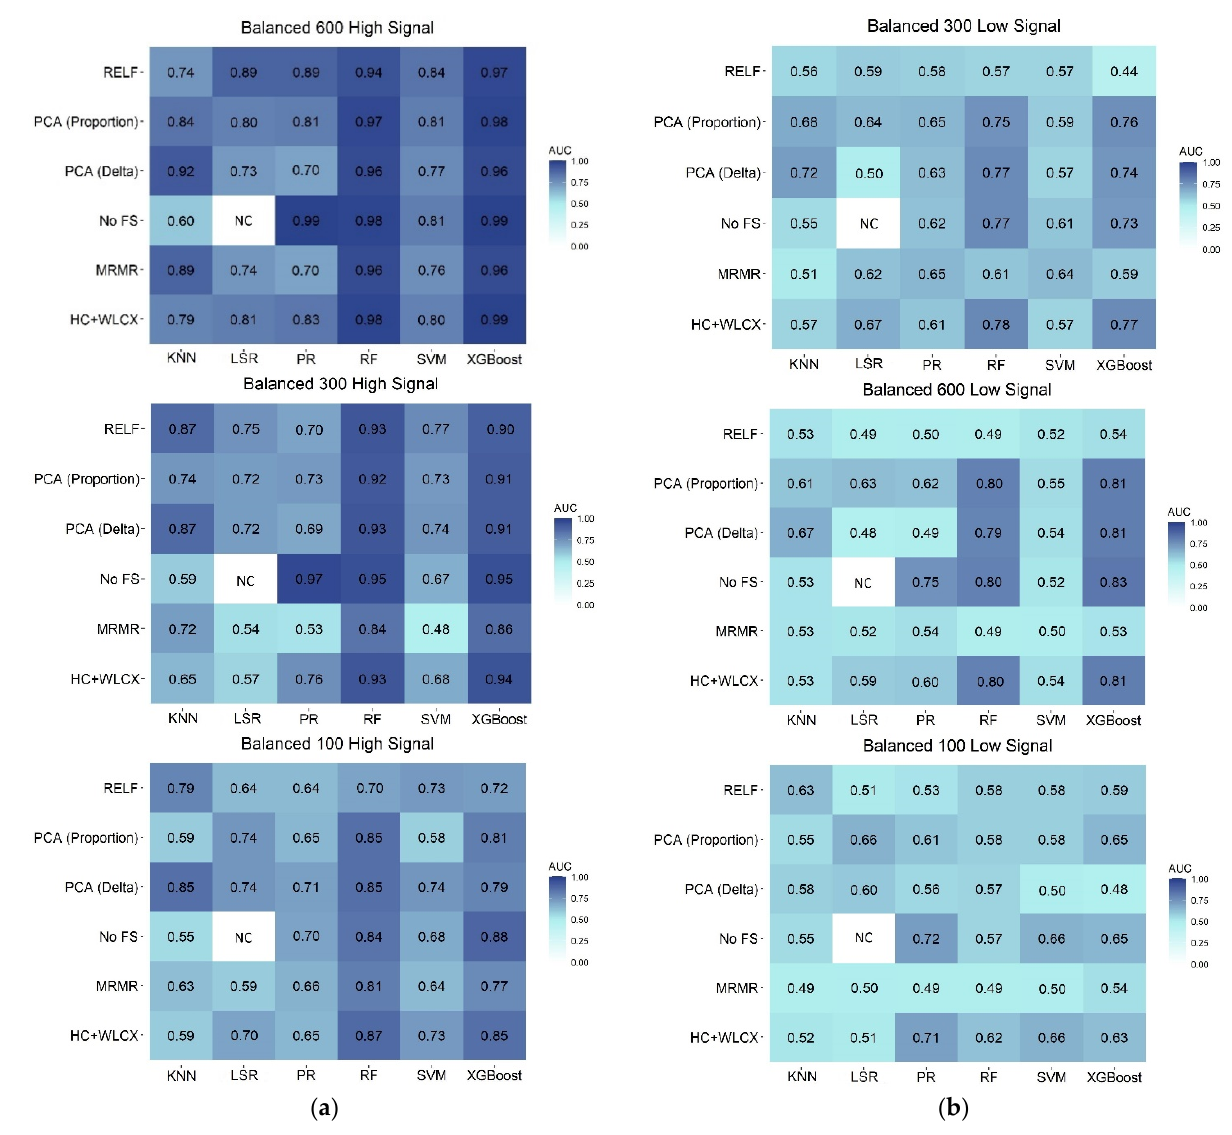
Figure 2. Heatmap representing the predictive performance (AUC) of feature selection (rows) and classification (columns) methods in the validation set for: ( a ) simulated samples with a high signal; ( b ) simulated samples with a low signal. HC + WLCX = Hierarchical clustering + Wilcoxon; KNN = K-Nearest Neighbor; LSR = Logistic Step-wise Regression; MRMR = Minimum Redundancy Maximum Relevance; PCA (Delta) = Principal Component Analysis clustering with Delta plot stop criterion + Wilcoxon; PCA (Proportion) = Principal Component Analysis clustering with proportion stop criterion + Wilcoxon; PR = Penalized Regression; RF = Random Forest; RELF = Relief; XGBoost = Extreme Gradient Boosting; SVM = Support Vector Machine.